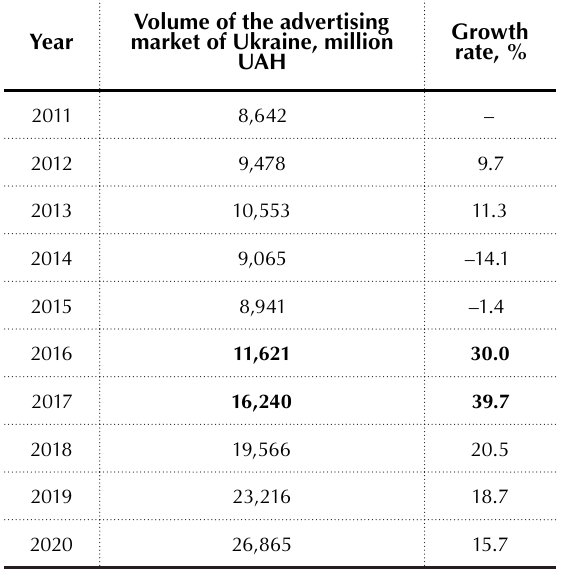
Carrying out recalculation of perspective volumes of the advertising market of Ukraine in USD, it